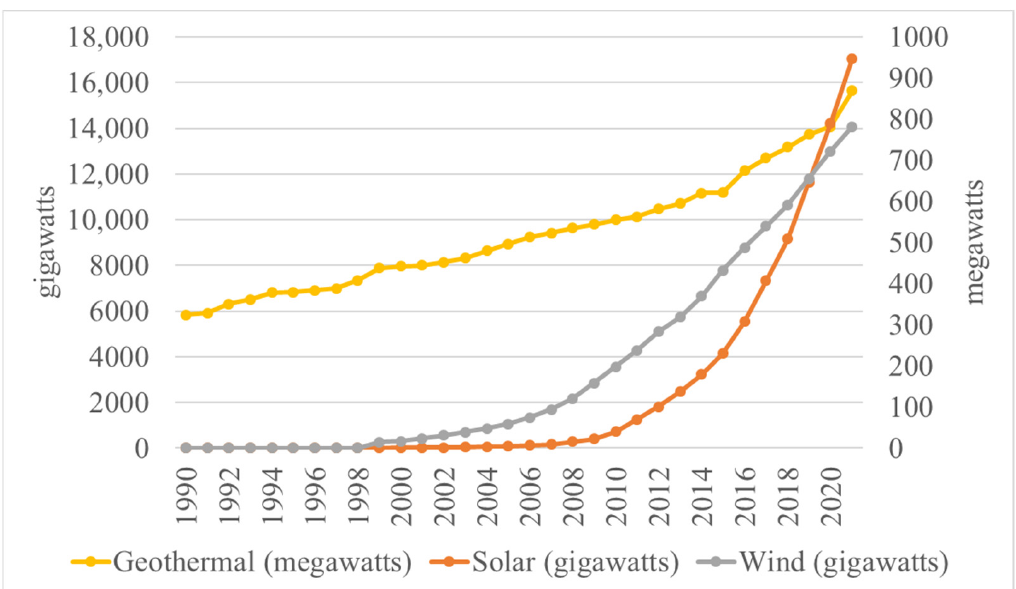
Figure 4. Global renewable energy capacity investment between 1990 and 2021.